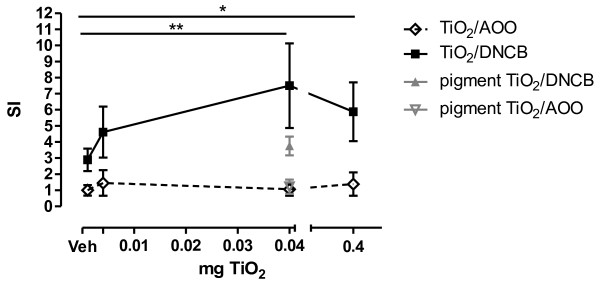
Effect of subcutaneous injections of TiO2NPs or pigment particles on the skin sensitizing capacity of 0.1% DNCB. Stimulation Index in lymph node proliferation assay (LNPA). To calculate the SI, all SI’s of the AOO-treated were pooled, since they were not statistically different from each other. Graph shows mean ± SD, n = 5–9, * p < 0.05 and ** p < 0.01.